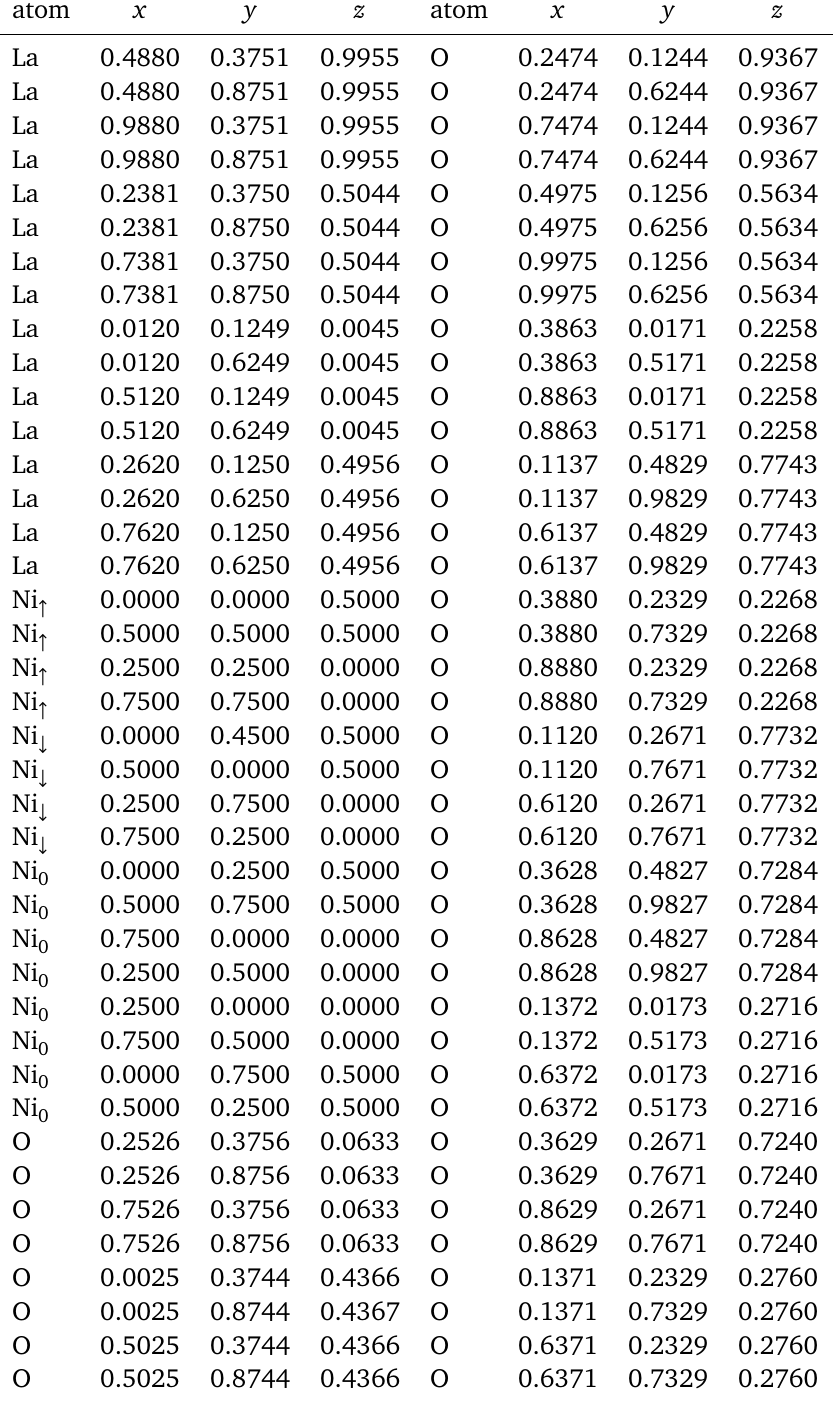
The relaxed atomic positions of the disproportionated antiferromag- netic P